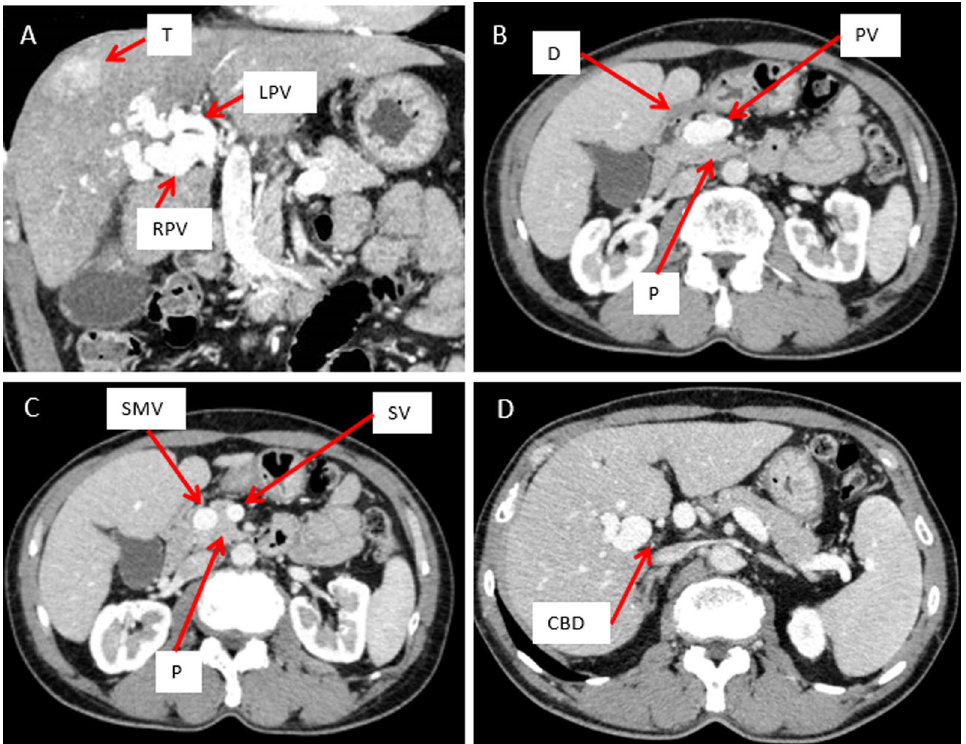
Fig. 2 Contrast-enhanced computed tomography findings (focused on portal vein). A Coronal view. Portal vein dilated in the hepatic hilus and bent and twisted while branching off. B , C Portal vein was lying ventral to the pancreas and dorsal to the duodenum. D Portal vein was lying ventral to the common bile duct. T tumor, RPV right portal vein, LPV left portal vein, D duodenum, PV portal vein, P pancreas, SMV superior mesenteric vein, CBD common bile